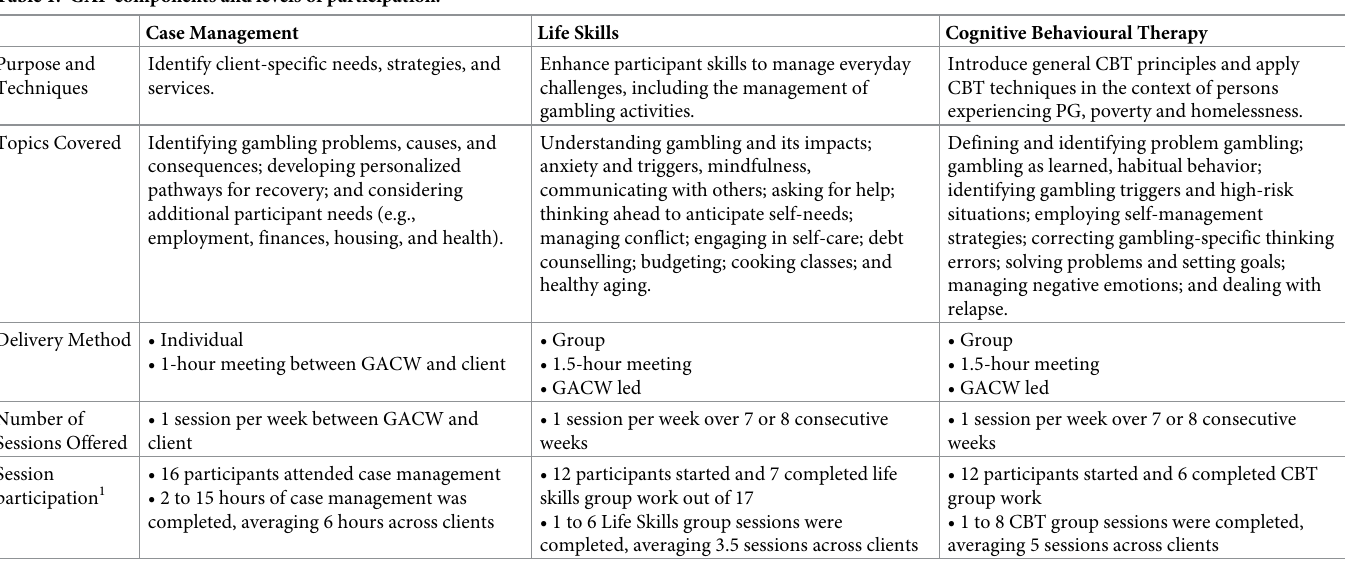
Table 1. GAP components and levels of